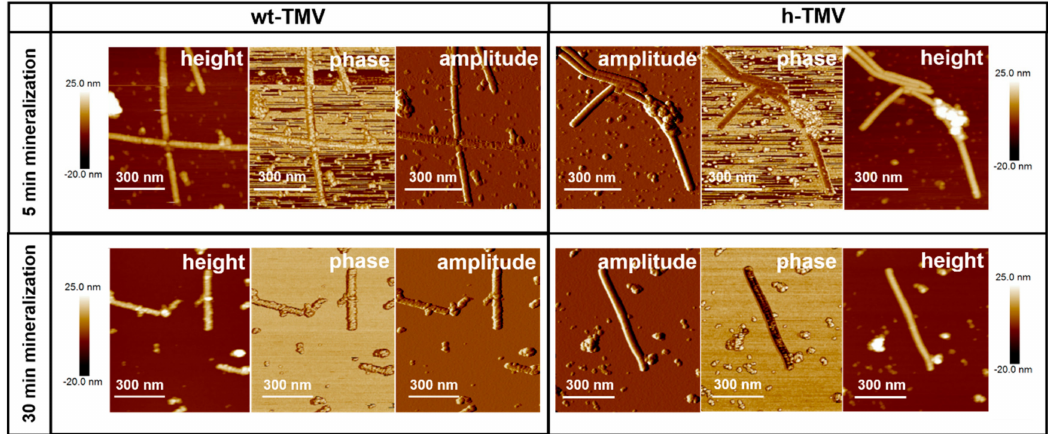
Figure 7. AFM height, amplitude and phase images of wt-TMV and h-TMV mineralized simultaneously with ZnS for 5 and 30 min,